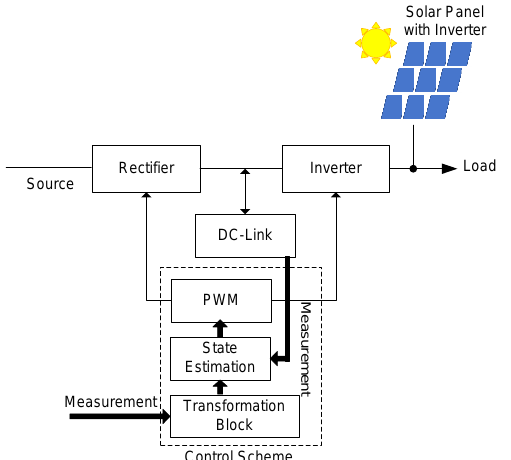
Figure 16. Configuration representation of a BESS model in grid support.